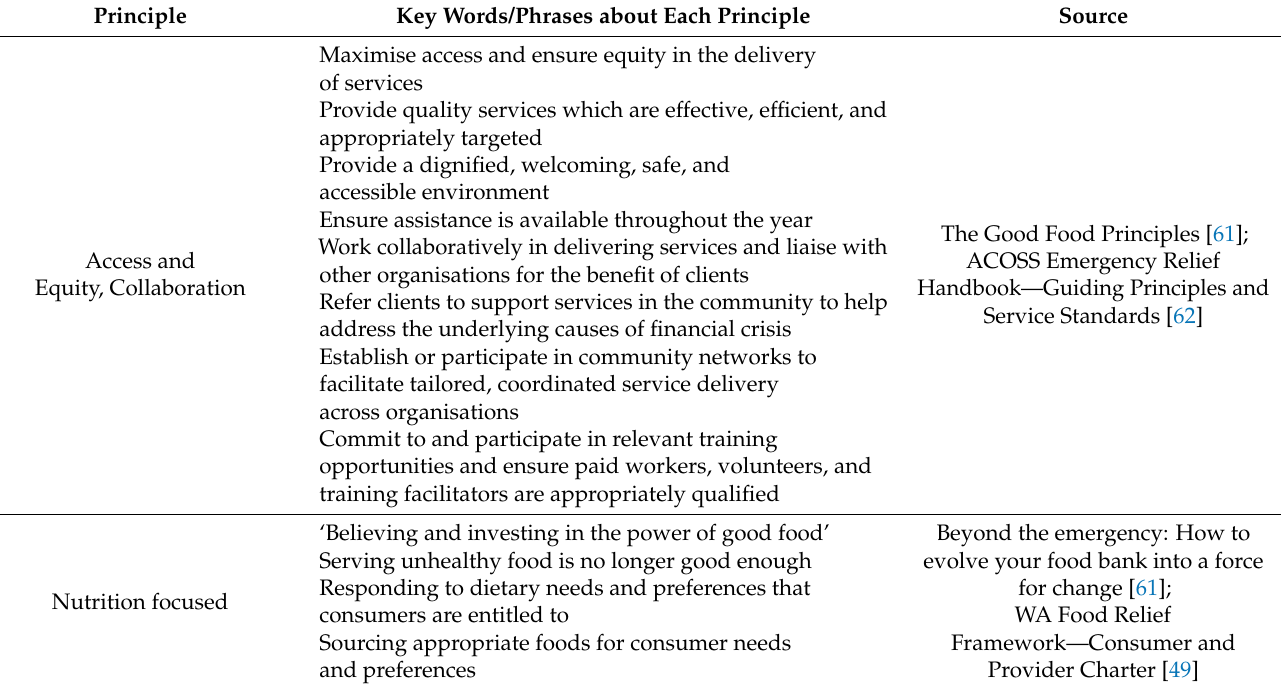
Table 1. Summary of guiding principles drawn from existing Charters/frameworks relevant to food relief service. Key Words/Phrases about Each